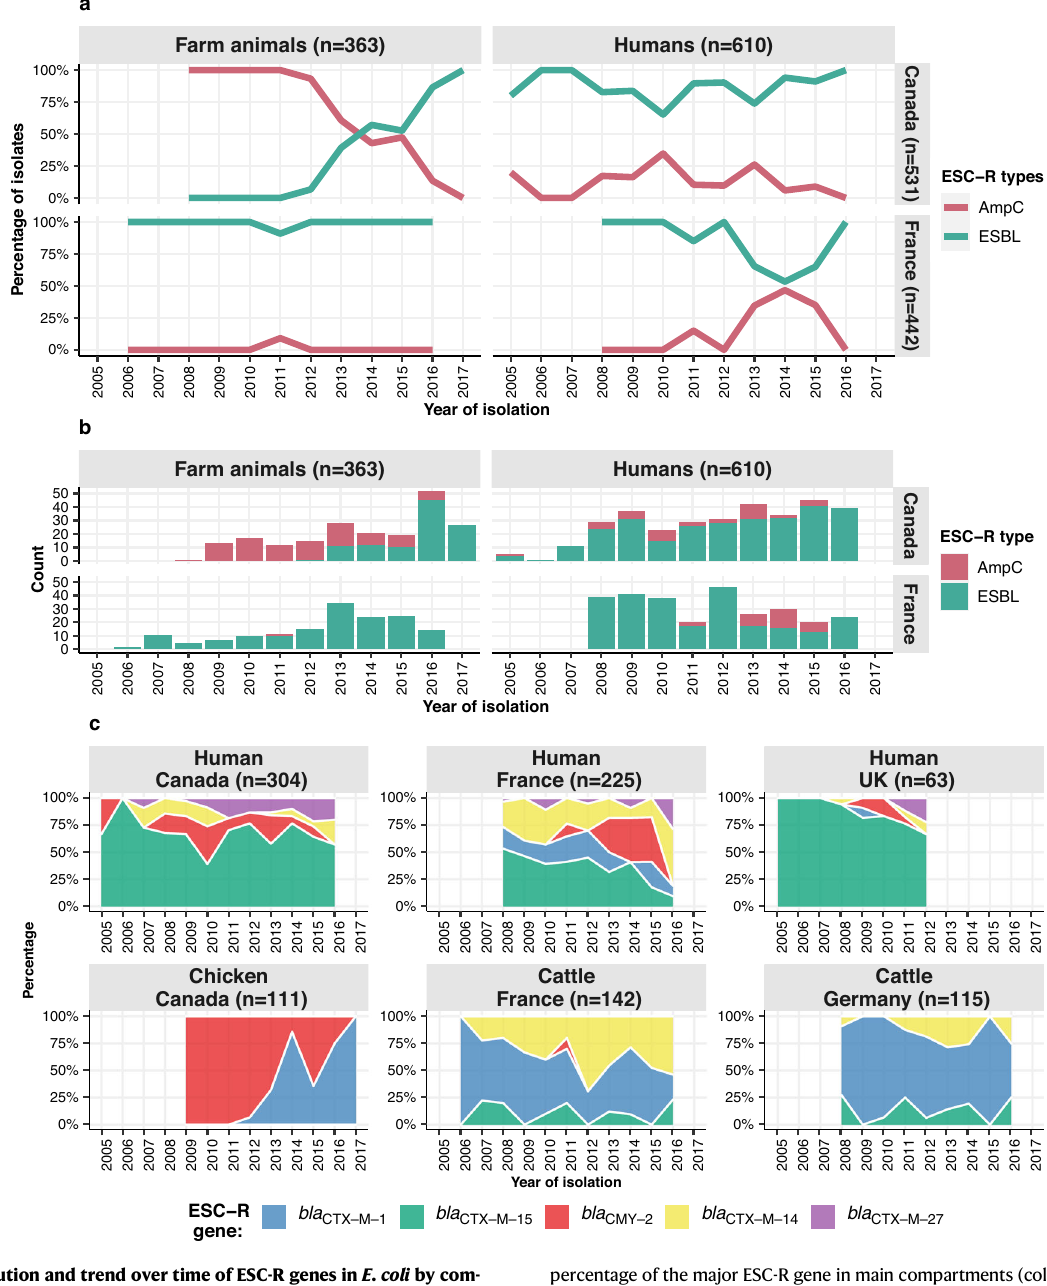
percentage of the major ESC-R gene in main compartments (colour key is in inset legend).SourcedataareavailableintheSourceData fi le.ESC-Rextended-spectrum cephalosporin resistance, ESBL extended-spectrum β